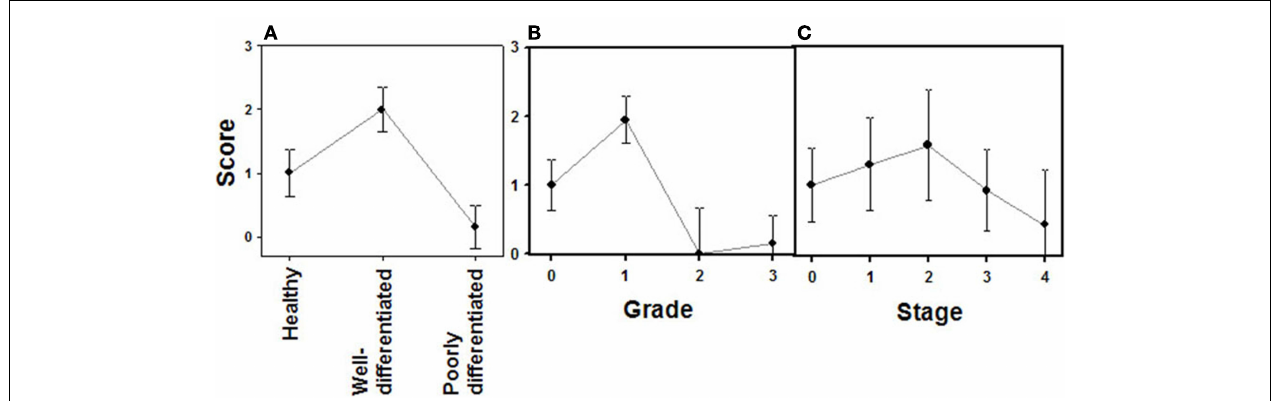
FIGURE 6 | Quantification of immunochemical staining of glypican 1 . (A) Relative to tumor differentiation. (B) Relative to tumor grade. (C) Relative to tumor stage. Semiquantitative scale from 0 to +++ was used.Vertical bars denote 0.95 confidence intervals.